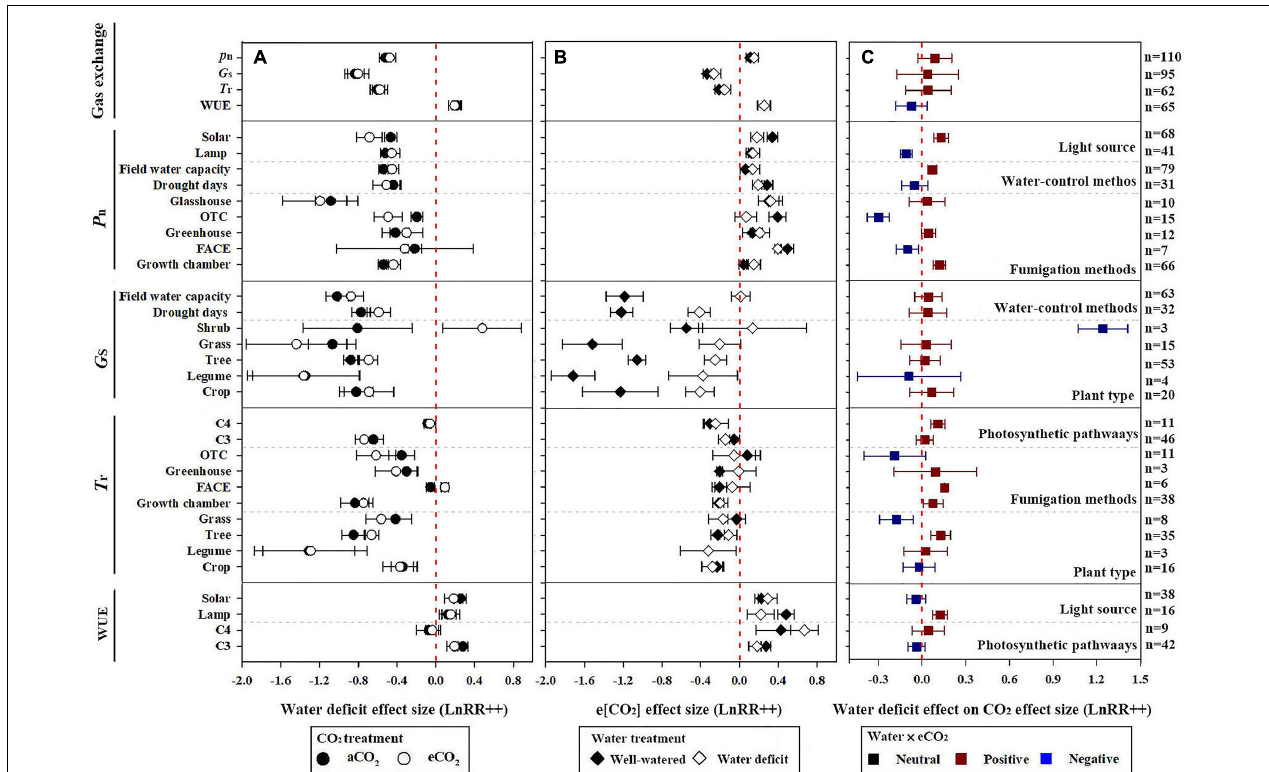
FIGURE 1 | Effect of water deficit and elevated CO 2 (e[CO 2 ]) on plant gas exchange variables. (A) Effect of water deficit under ambient CO 2 (a[CO 2 ]), black circle, and e[CO 2 ], white circle; (B) effect of e[CO 2 ] under well-watered (white diamond) and water deficit (black diamond) conditions; and (C) effect of water deficit on plant response to e[CO 2 ]: red, blue, and black boxes represent positive, negative, and statistically neutral effects, respectively. Response variables are as follows: net photosynthesis ( P n ), stomatal conductance ( G s ), transpiration rate ( T r ), and leaf-level water use efficiency (WUE = P n / T r ). Water-deficit and e[CO 2 ] treatment effect on plant P n was classified according to light source, control methods of water, and CO 2 fumigation methods; G s was classified according to plant type and control methods of water; T r was classified according to photosynthetic pathways, plant type, and CO 2 fumigation methods; and WUE was classified according to light source and photosynthetic pathways (all separated by dotted lines). Dots and error bars represent means and 95% CI, respectively, of the log-transformed response ratio estimated based on a random effect model. LnRR(++) represent weighted mean response ratios. Number of data entries for each variable is denoted as n , labeled on the right y -axis. The treatment response was significant ( p < 0.05) if the CI did not intersect with the red vertical dotted line on each plot ( x =